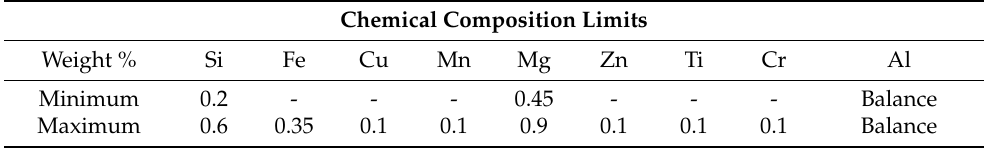
Table 1. Nominal compositions of AA6063-T6, measured by Foundry-Master Pro2 optical emission